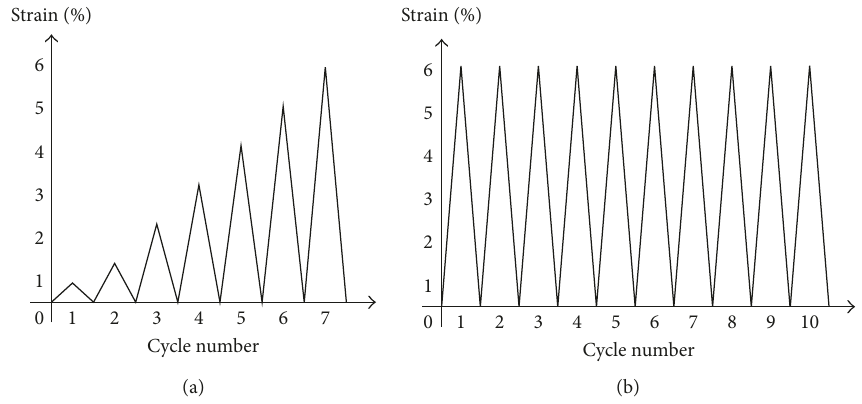
Figure 3: Two basic loading protocols. (a) LPI and (b)